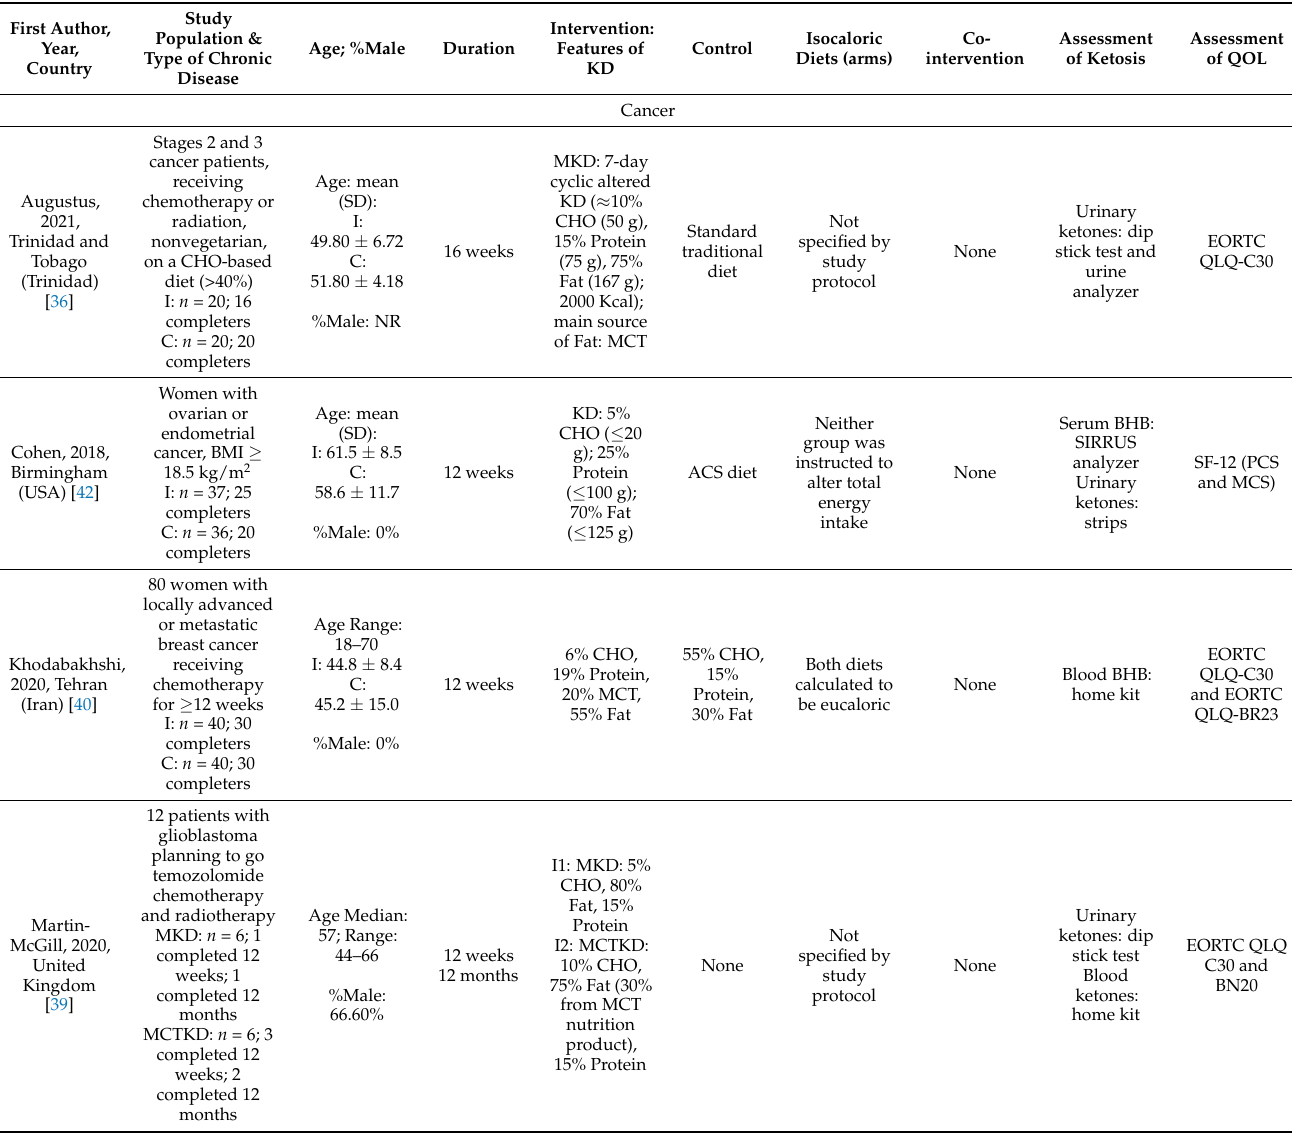
Table 1. Characteristics of the included